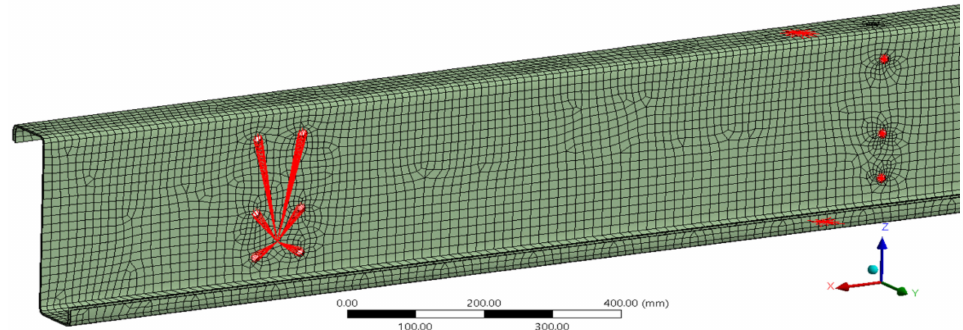
Figure 9. Detail of remote displacement in supporting the ends of beams and placing transverse